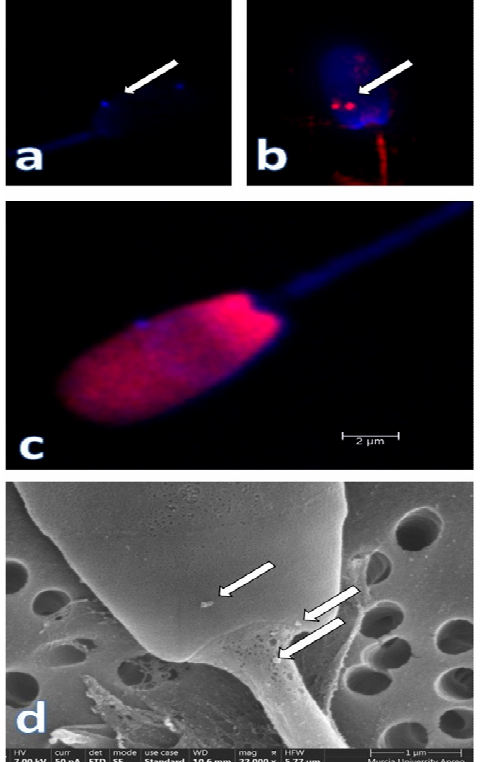
Figure 4. Seminal plasma extracellular vesicles (EVs) attached to the plasmalemma of ejaculated pig spermatozoa (arrows). Confocal microscopy microphotographs show the CD63 ( a ) (blue, Alexia fluor 405) and CD9 ( b ) (red, phycoerythrin, arrows) immunostained EVs. In ( c ), a composite image of a spermatozoon stained with Hoechst 33,342 and propidium iodide, while a scanning electron microscopy (SEM) micrograph showing some EVs attached to the membrane in the neck and head sperm domains is shown in ( d ). Courtesy of our graduates L Padilla and I Barranco.